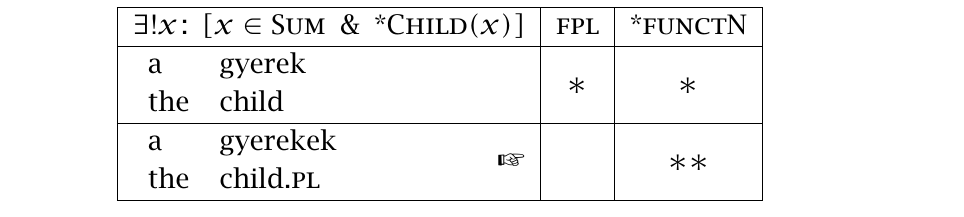
Tableau 2 expressive optimization for definite plurals (Hungarian) layer above NP. 28 Fpl : Sum reference must be encoded in the functional structure of the